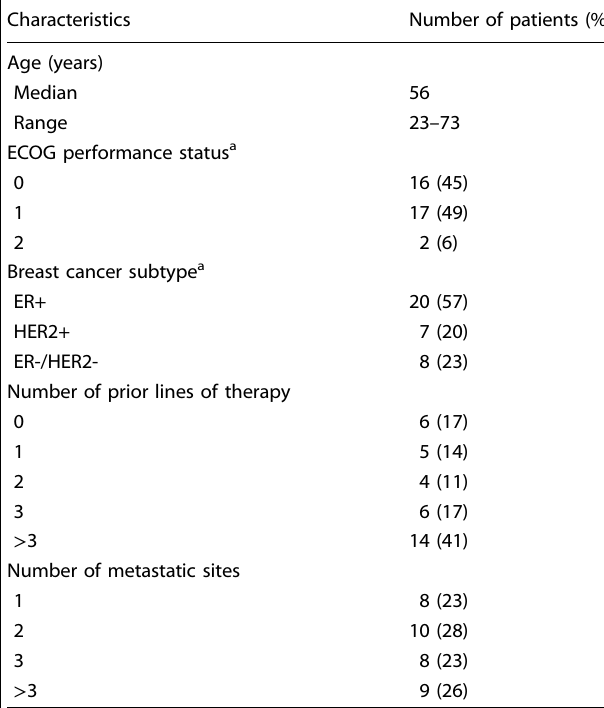
Table 1. Clinical and pathological characteristics of patients and biopsies ( n =